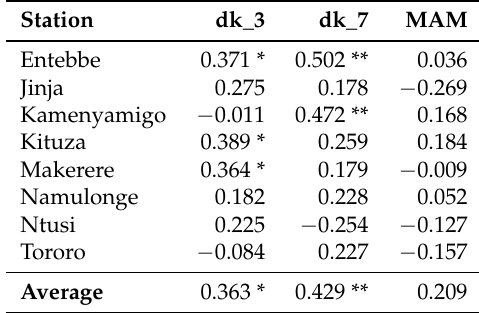
Figure 8. Figure representing the percentage of dry consecutive days over the period 2000–2015. Table 8. Trend of extreme